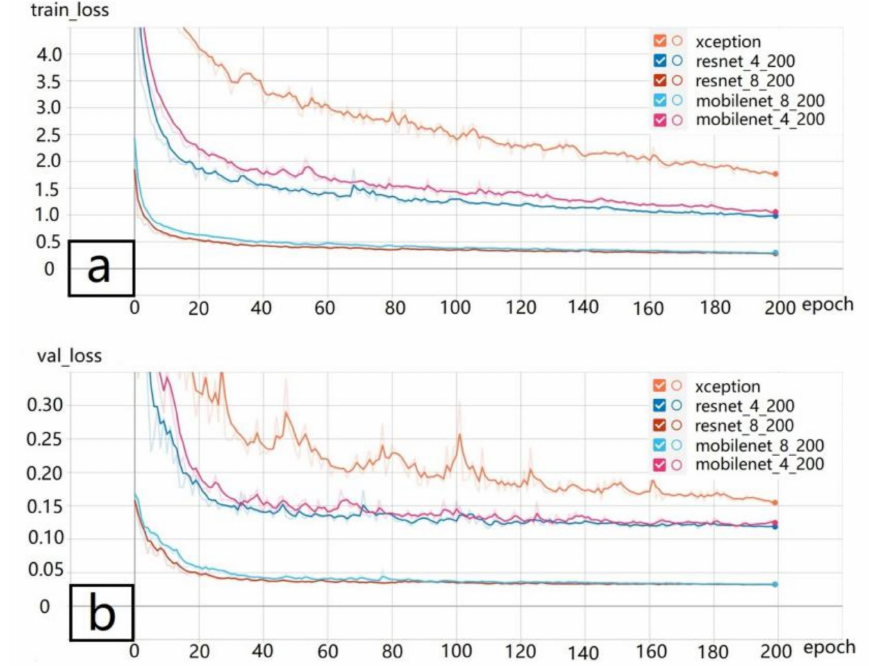
Figure 8. Loss function change curve. ( a ): Training dataset; ( b ): Verification